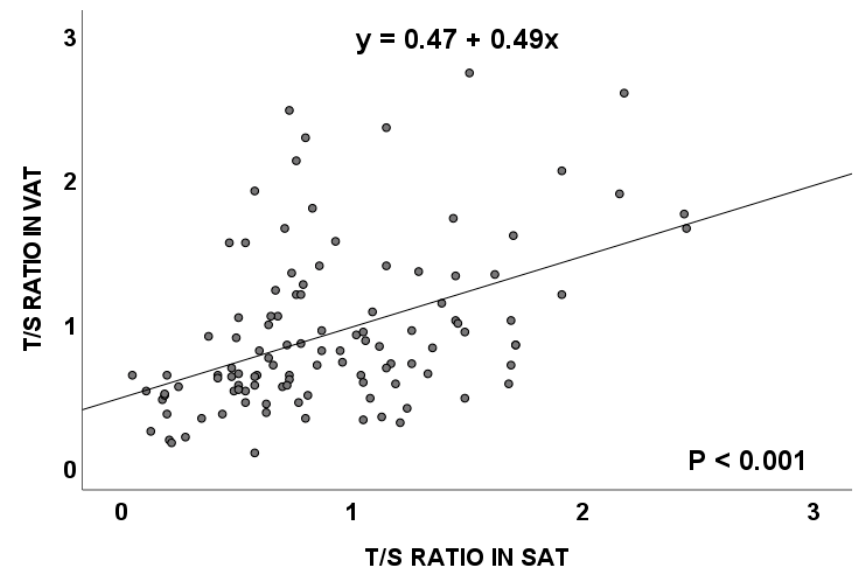
Figure 1. Telomere length (measured as T/S ratio) correlation between visceral and subcutaneous adipose tissues in the total population. VAT: visceral adipose tissue; SAT: subcutaneous adipose tissue. This significant correlation between the T/S ratio in the visceral and subcutaneous adipose tissues was maintained in overweight subjects (Figure 2A) and in obese individuals subject’s age ( p = 0.733, Spearman’s rho).